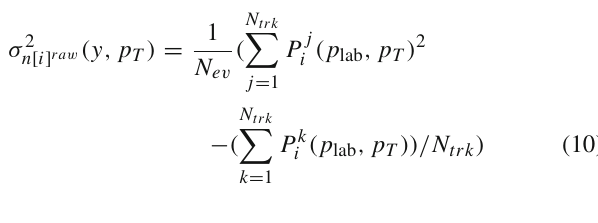
40 A GeV / c . Lines show projections of the fits for pions (red), kaons (green), protons (blue) and electrons (magenta). Bottom right panel shows the fit